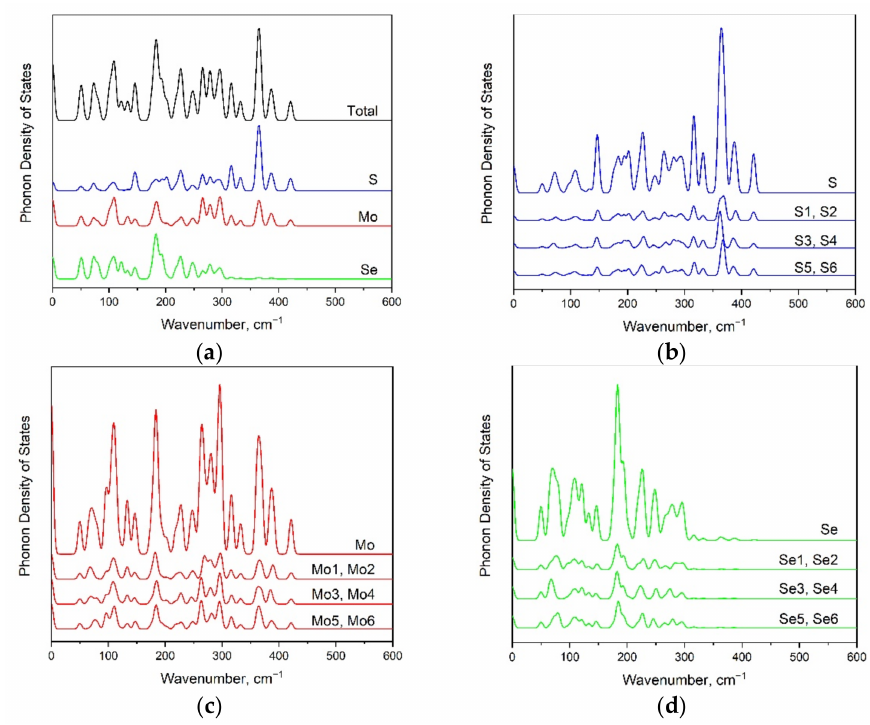
Figure 10. Total ( a ) and partial ( b – d ) phonon density of states for 1H’ MoSSe